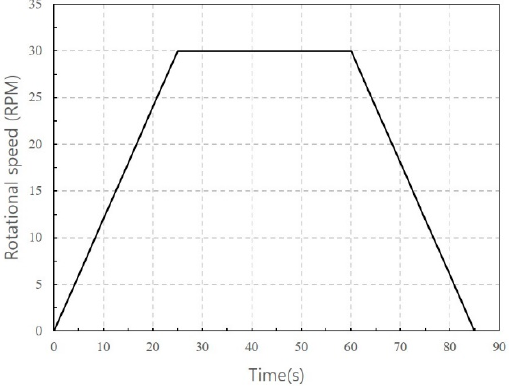
Figure 5. Paddle control program for rheology test.